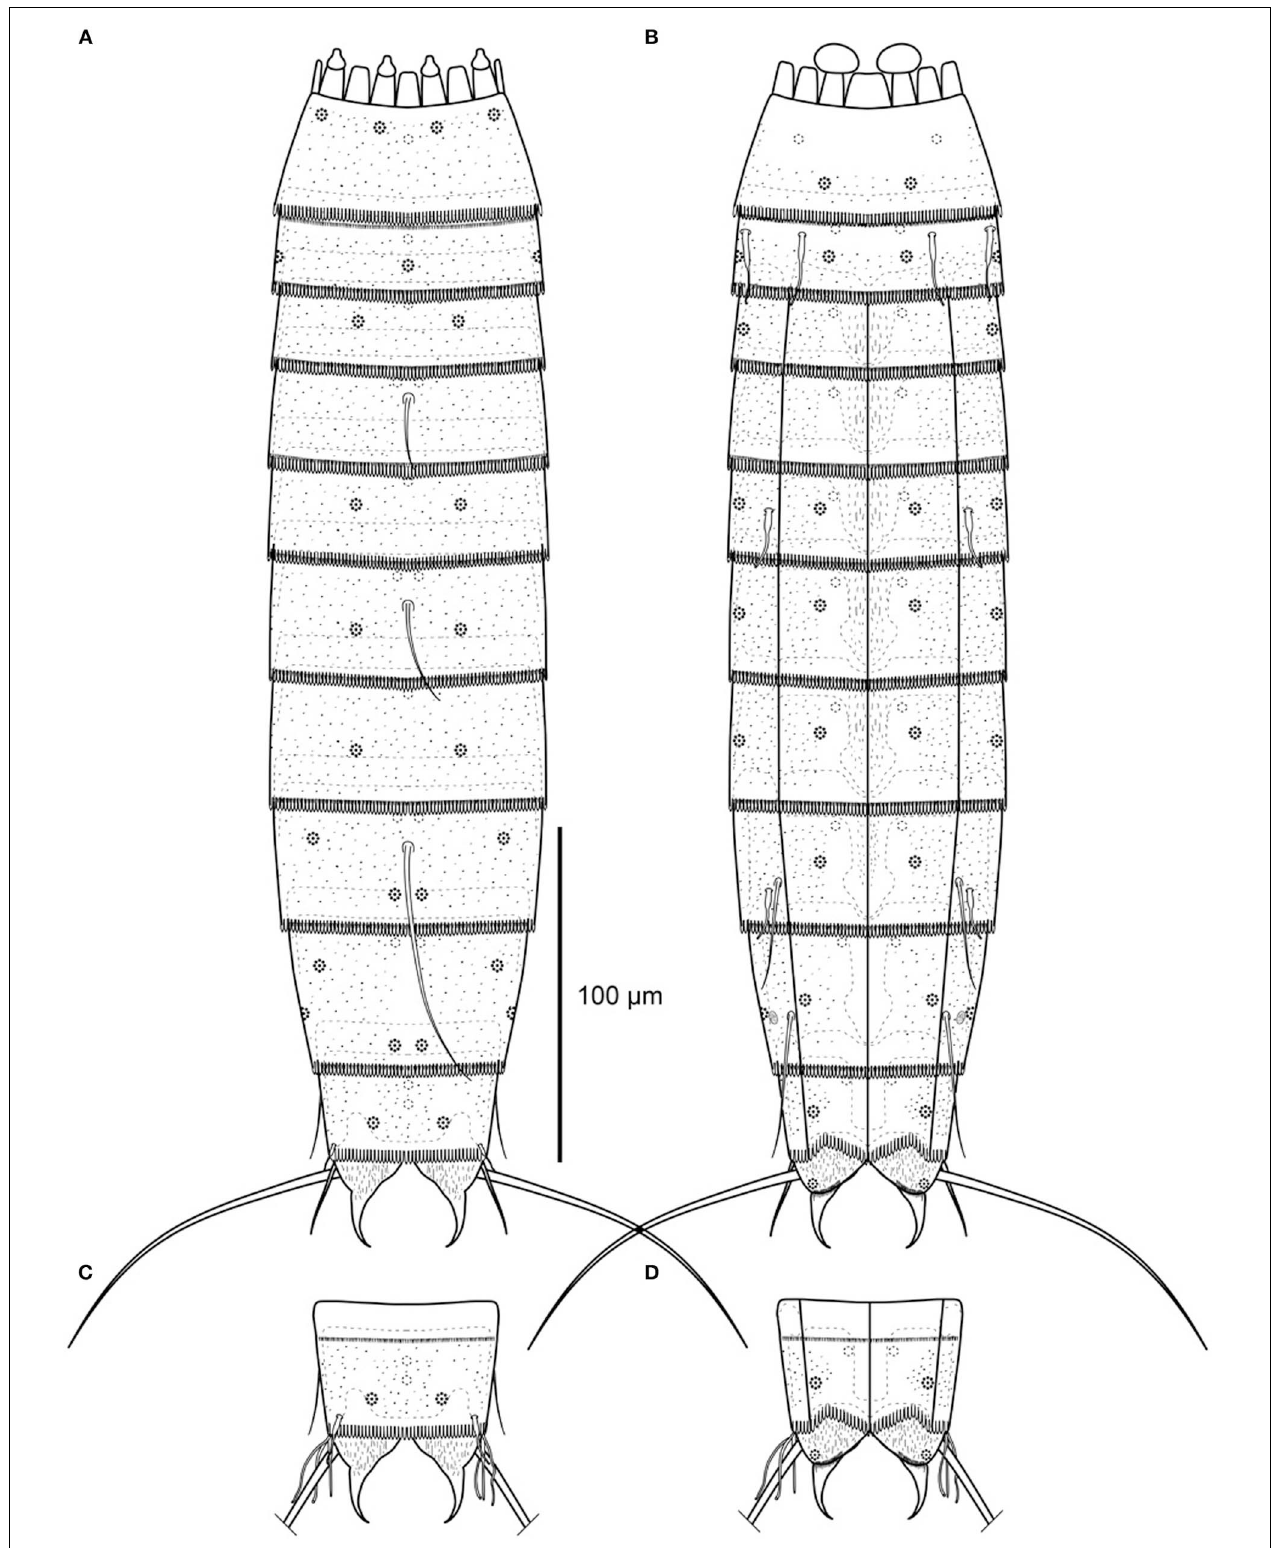
FIGURE 6 | Line art illustrations of Echinoderes skipperae sp. nov. (A) Female, dorsal view. (B) Female, ventral view. (C) Male, segments 10 to 11, dorsal view. (D) Male, segments 10 to 11, ventral view.